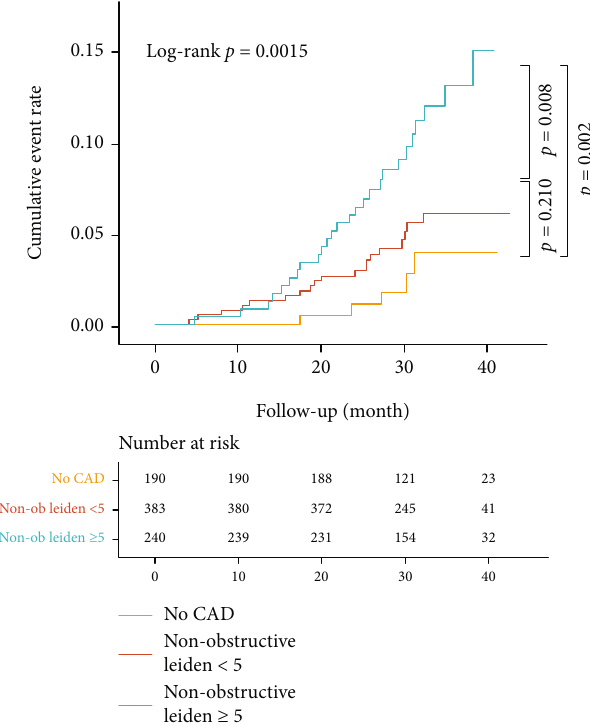
Figure 2: Cumulative risk of the composite endpoint on the basis of CAD severity with Leiden risk score (no CAD, nonobstructive CAD with Leiden < 5 , and nonobstructive CAD with Leiden ≥ 5 ). CAD: coronary artery